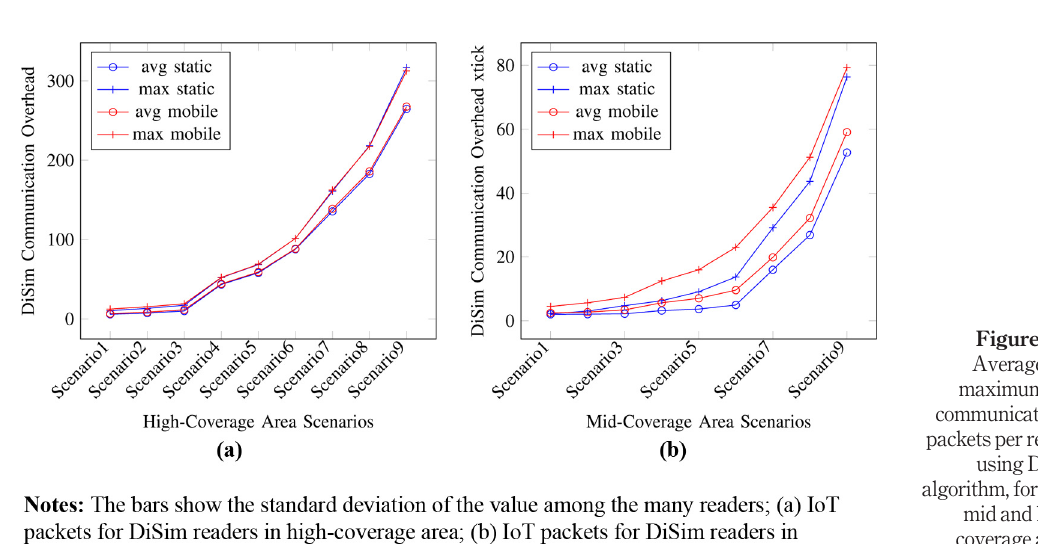
Figure A5. Average success rate of tag-reading operations for static and mobile readers, for both mid and high-coverage areas